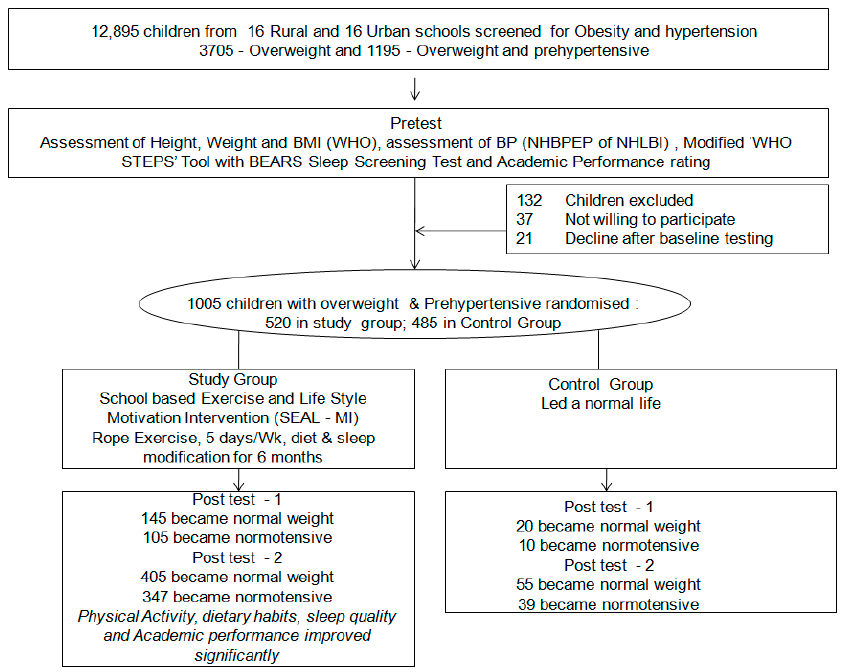
Figure 1. CONSORT flow diagram of the study.